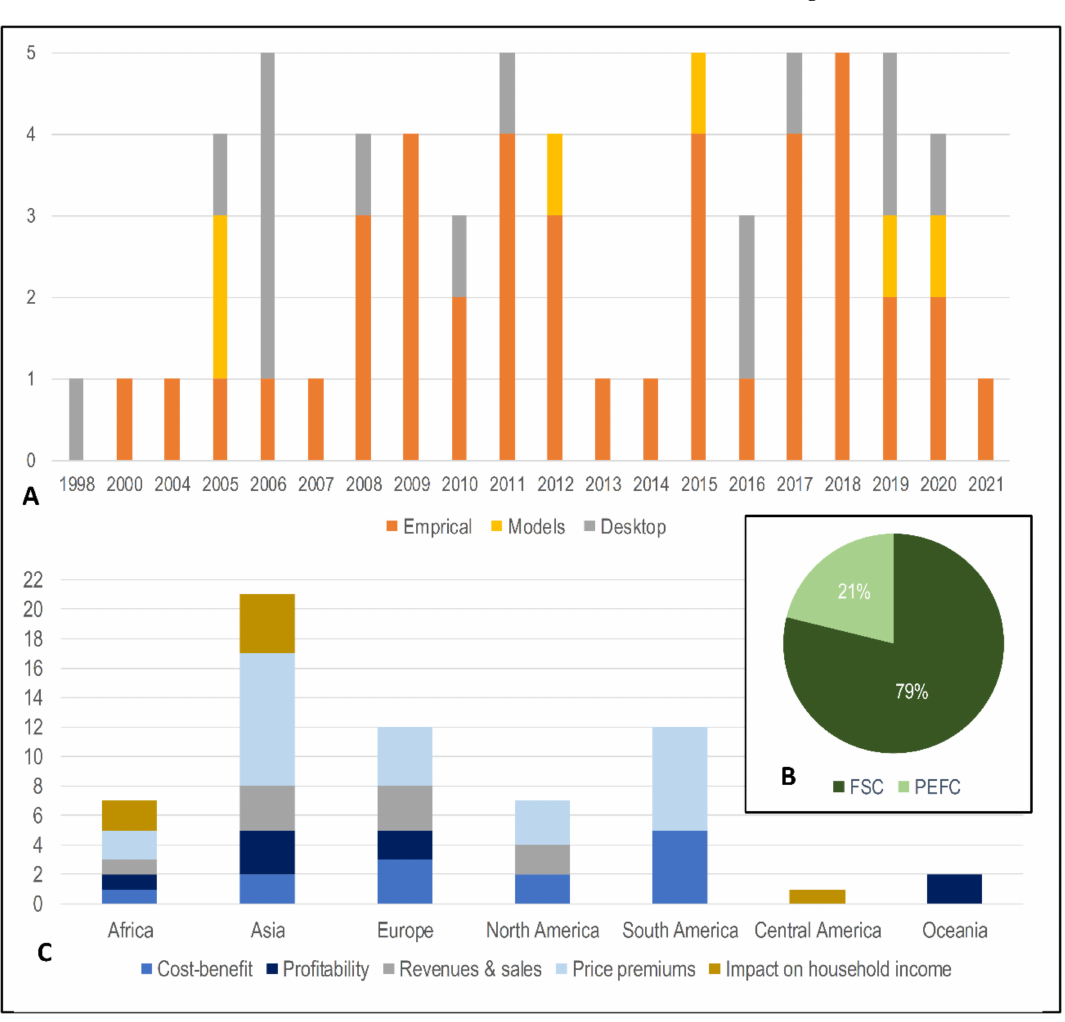
Figure 8. Number of publications on economic viability presented by publication year and publication type ( A ). Share of certification scheme studied in the case studies ( B ). Distribution of empirical case studies, presented per world region and indicator (is not equal to the number of studies) ( C